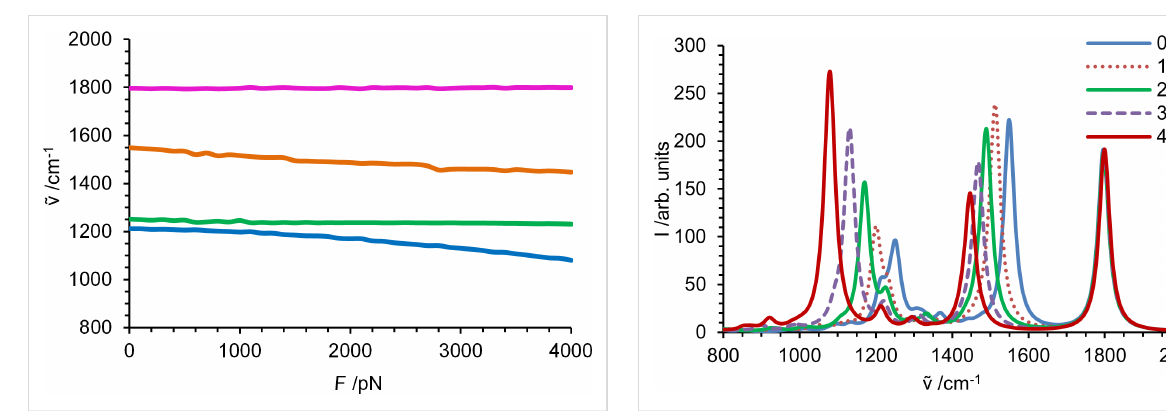
red shifted, but significantly broadened. Moreover, the broad- ening leads to a significantly decreased peak height of the band around 1550 cm − 1 . The band around 1250 cm − 1 is composed of several vibrational modes, and their different force dependence leads to seemingly erratic changes in peak shape. Interestingly, the change in the peak shape with increasing force resembles the experimentally observed difference between bulk and sur- face spectra reported by Vettegren and co-workers [27].